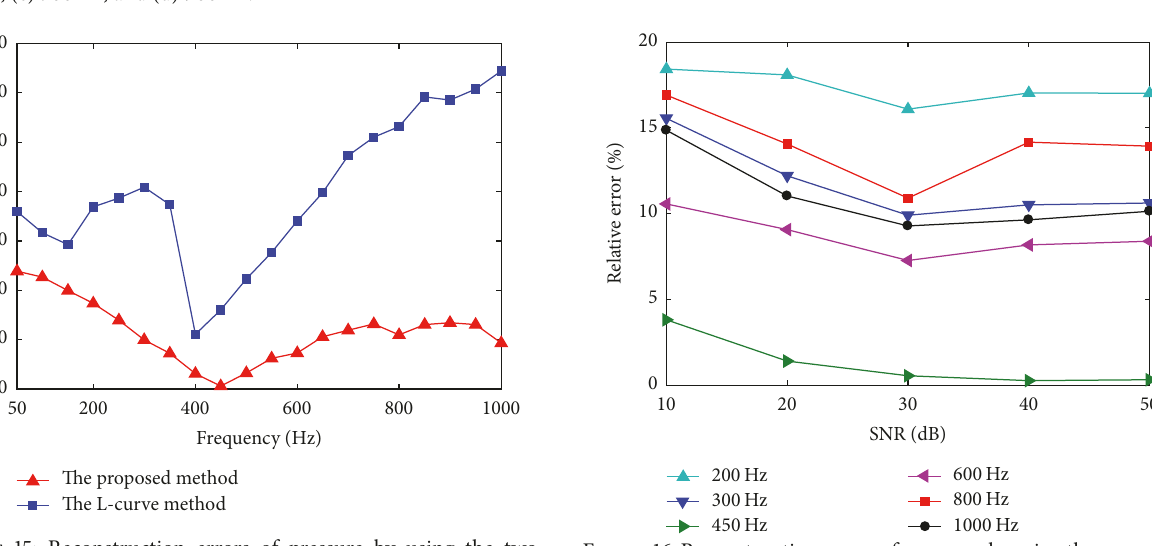
Figure 16: Reconstruction errors of pressures by using the proposed method versus